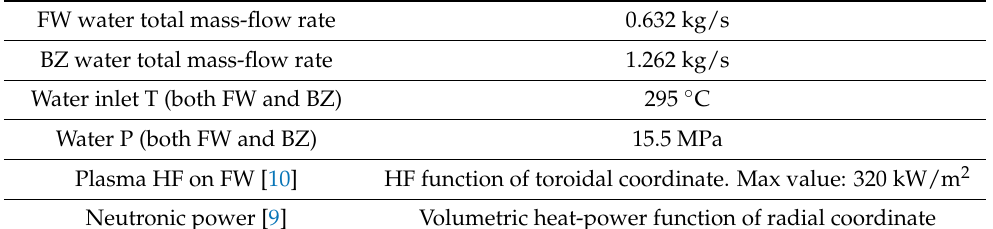
Table 3. Main boundary conditions used in the the FW reference simulation (COB in normal steady- state operational conditions).